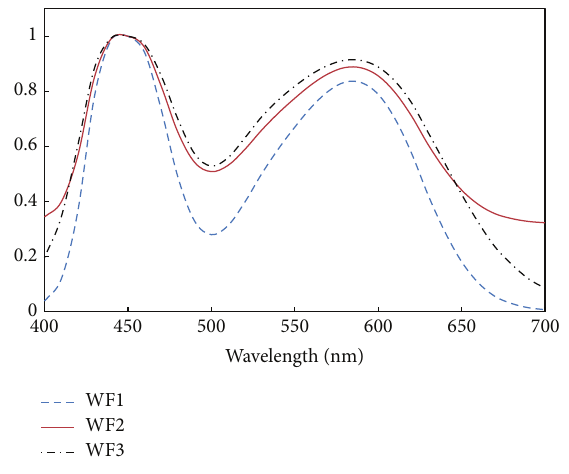
Figure 1: The weigh function 𝑤(𝜆)